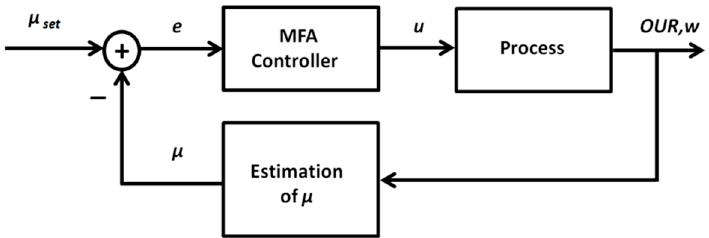
Figure 6. General structure of the adaptive artificial neural network (ANN)-based control system for specific growth rate control.